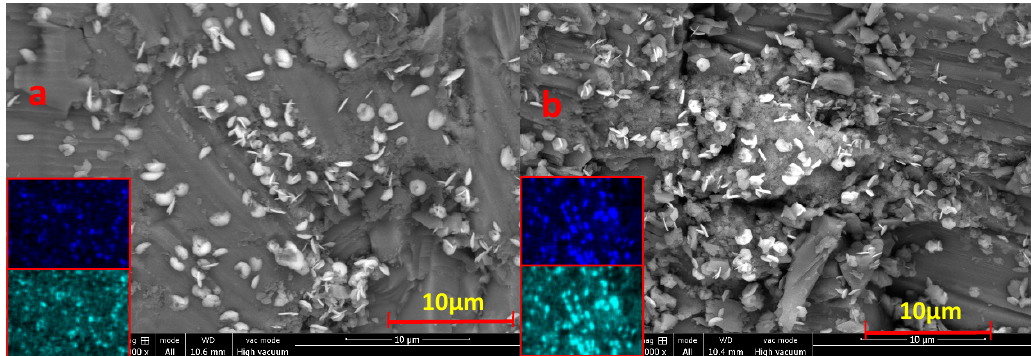
Figure 6. SEM–EDS results for the samples: ( a ) hemimorphite + Na 2 S·9H 2 O + Pb 2+ ; ( b ) hemimorphite + Pb 2+ + Na 2 S·9H 2 O + Pb 2+ .